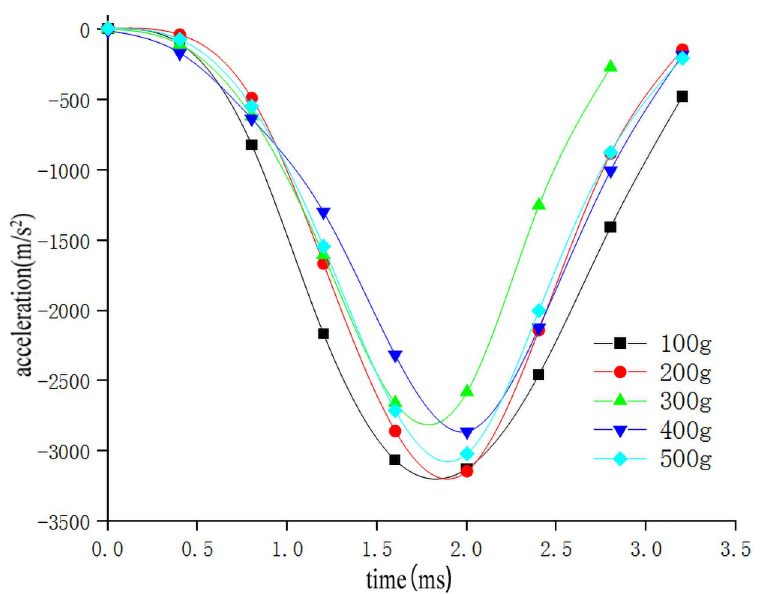
Fig 16. Acceleration-time relationship of different sizes of sweet potato falling.